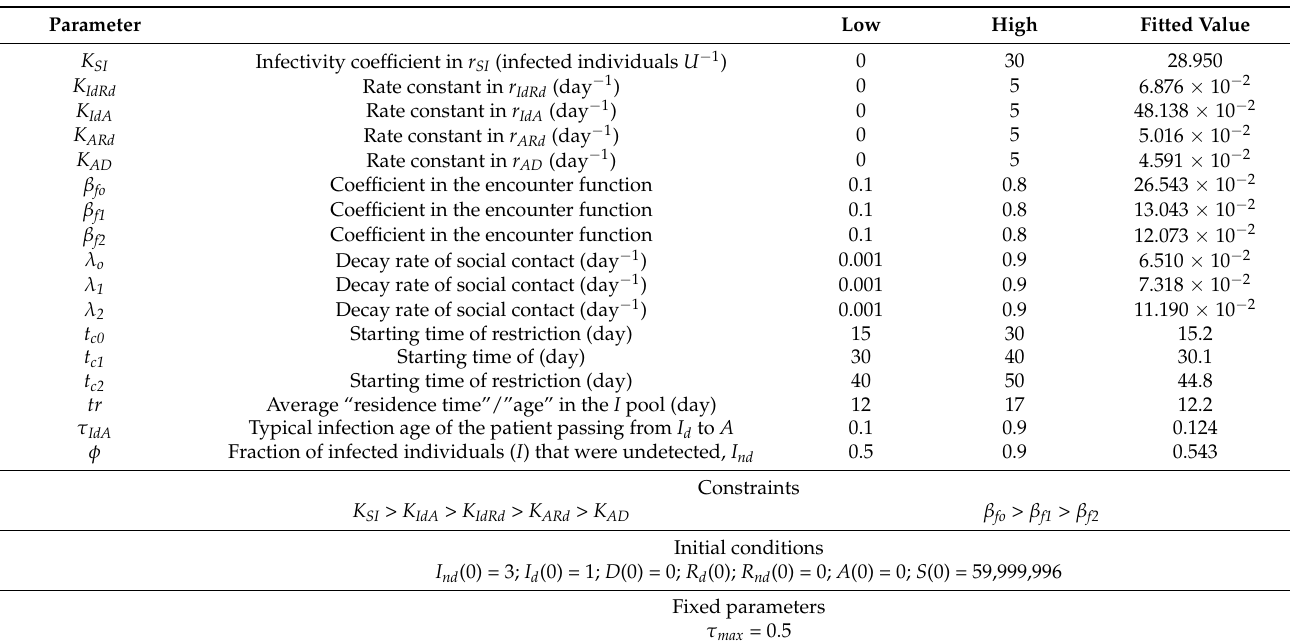
Table 1. Displays a summary of the parameters identified with the genetic algorithm for the early development of the COVID-19 in Italy. The range of the boundary values (low and high), initial conditions, constraints and fixed parameters during the optimization process are